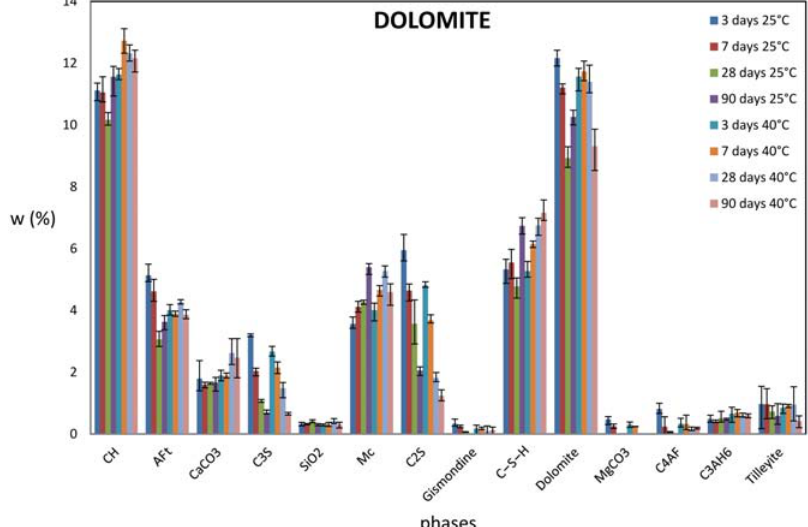
Figure 6. The quantitative analysis of hydration products in cements with added dolomite at 3, 7, 28 and 90 days of hydration and two tempera- tures, 25 and 40